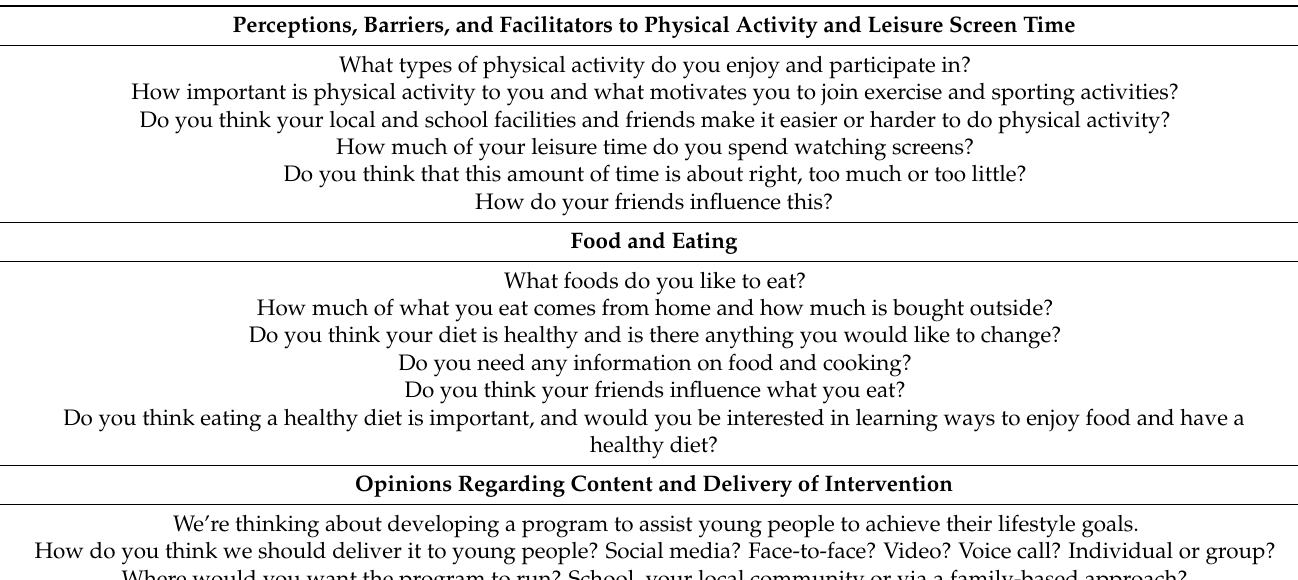
Table 1. Questions used in focus groups to gather information on the capabilities, opportunities and motivations of adolescents on weight-related behaviours and preferences regarding content and delivery of interventions.